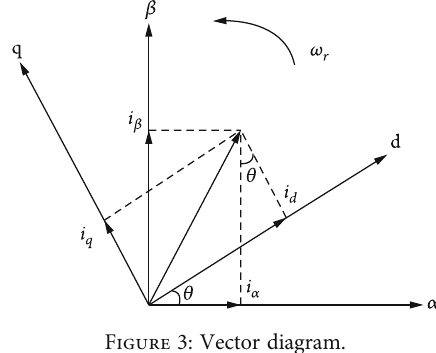
Figure 3: Vector